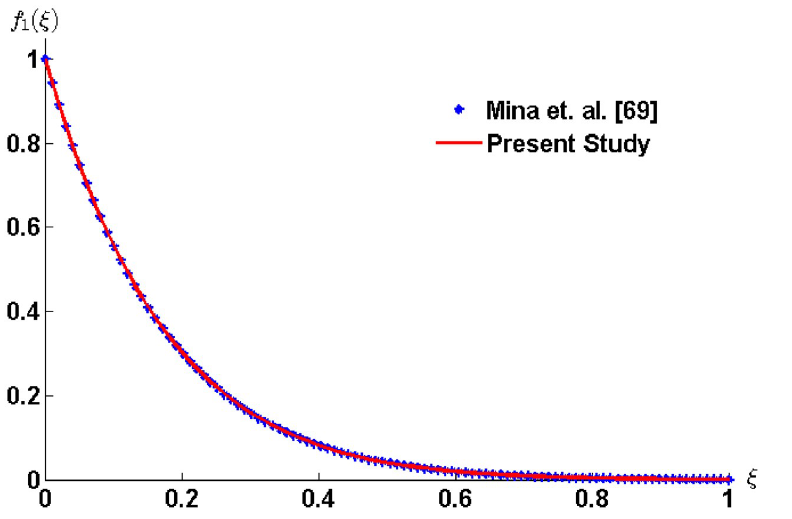
Fig 2. Comparison with Mina et al . [69] in the absence of nanoparticles and for n =